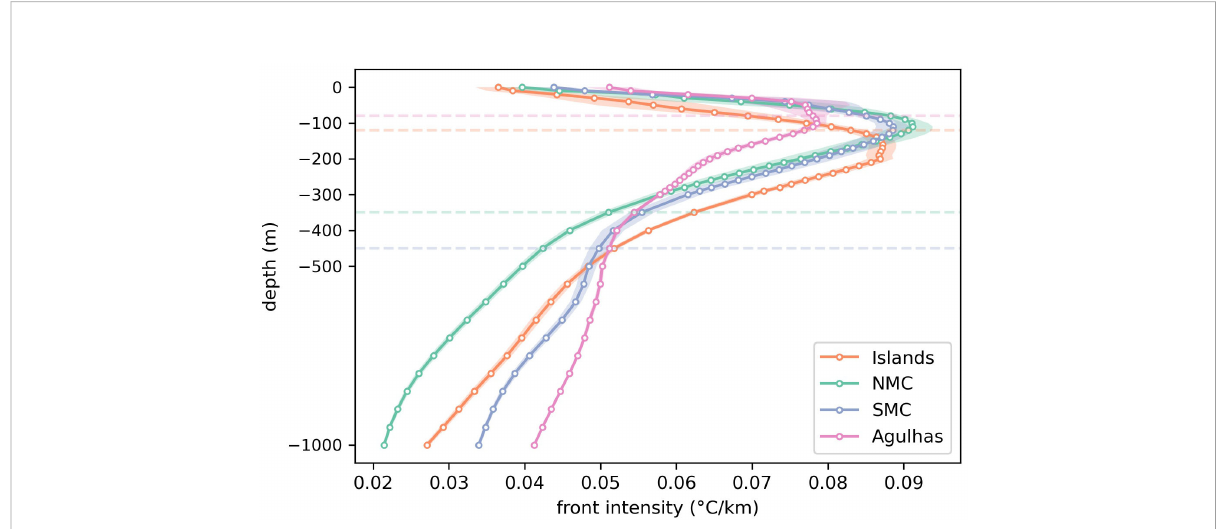
FIGURE 3 Mean temperature front intensity for each MOZ36 subregion in °C/km. The shading shows the seasonal standard deviation from the mean. The dashed horizontal lines mark the depth below which the seasonal standard deviation of temperature front intensity is lower than 5% of its